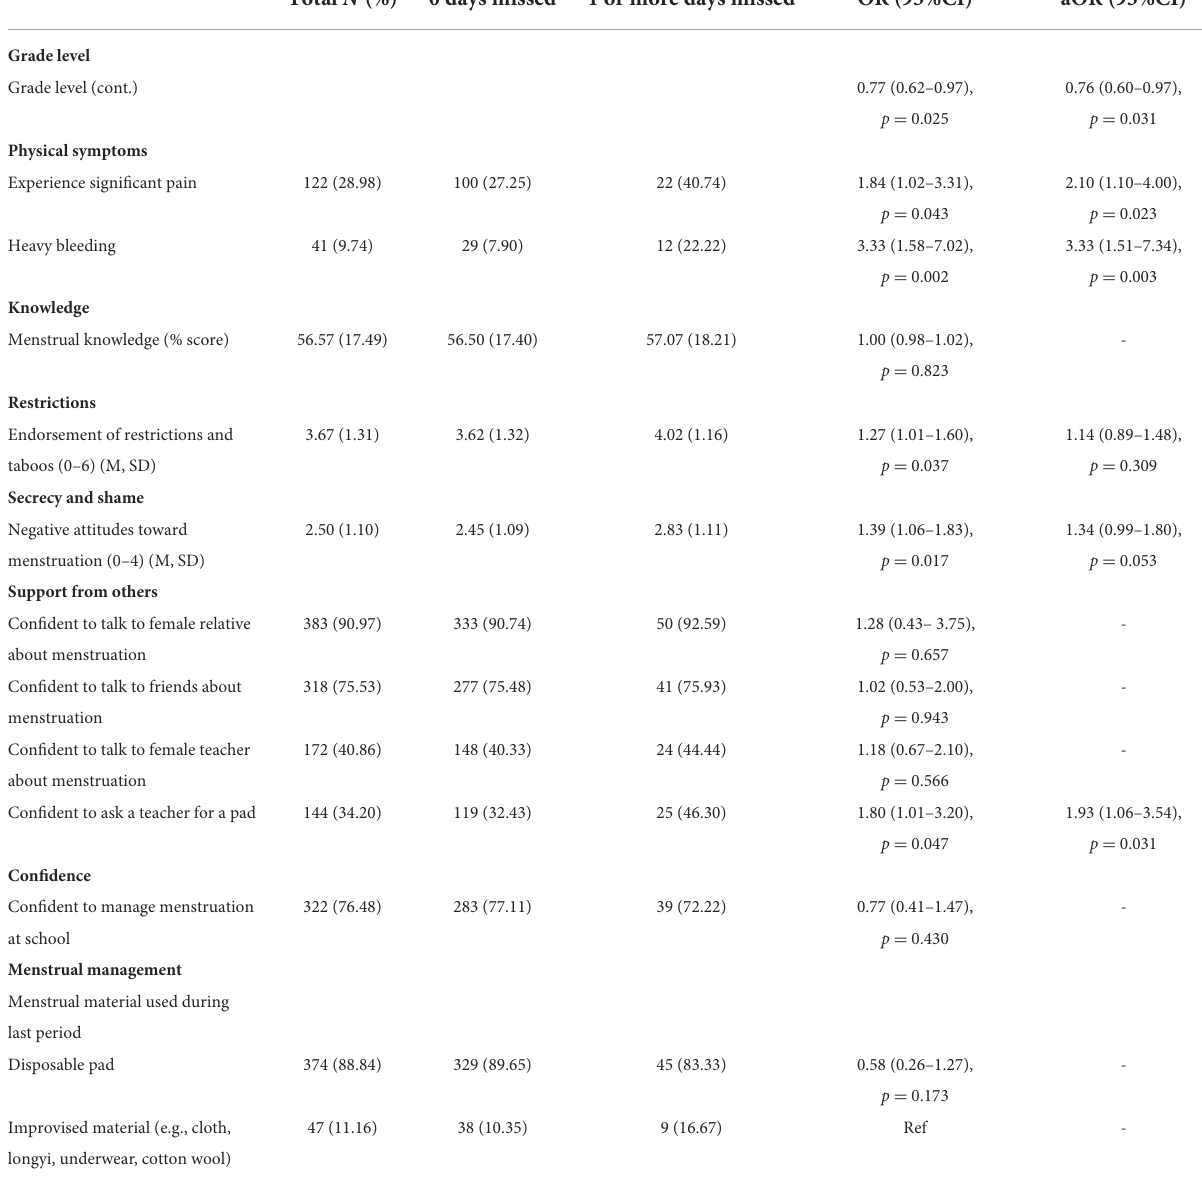
TABLE 2 Bivariate and multivariable associations between menstrual health challenges and menstrual-related school absenteeism. Total N (%) 0 days missed 1 or more days missed OR (95%CI) aOR (95%CI) Grade level Grade level